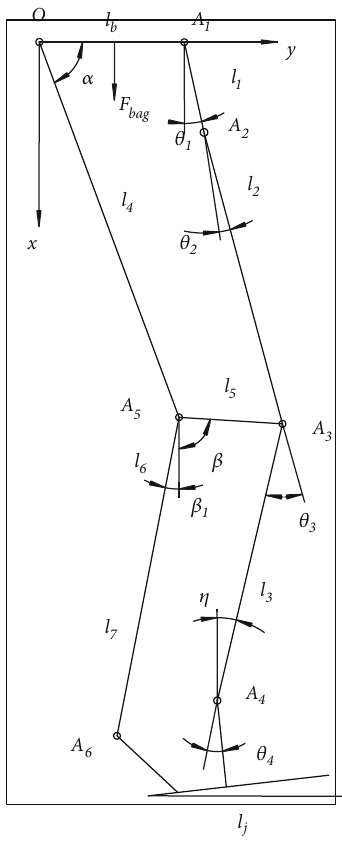
Figure 3: The schematic model of the swing